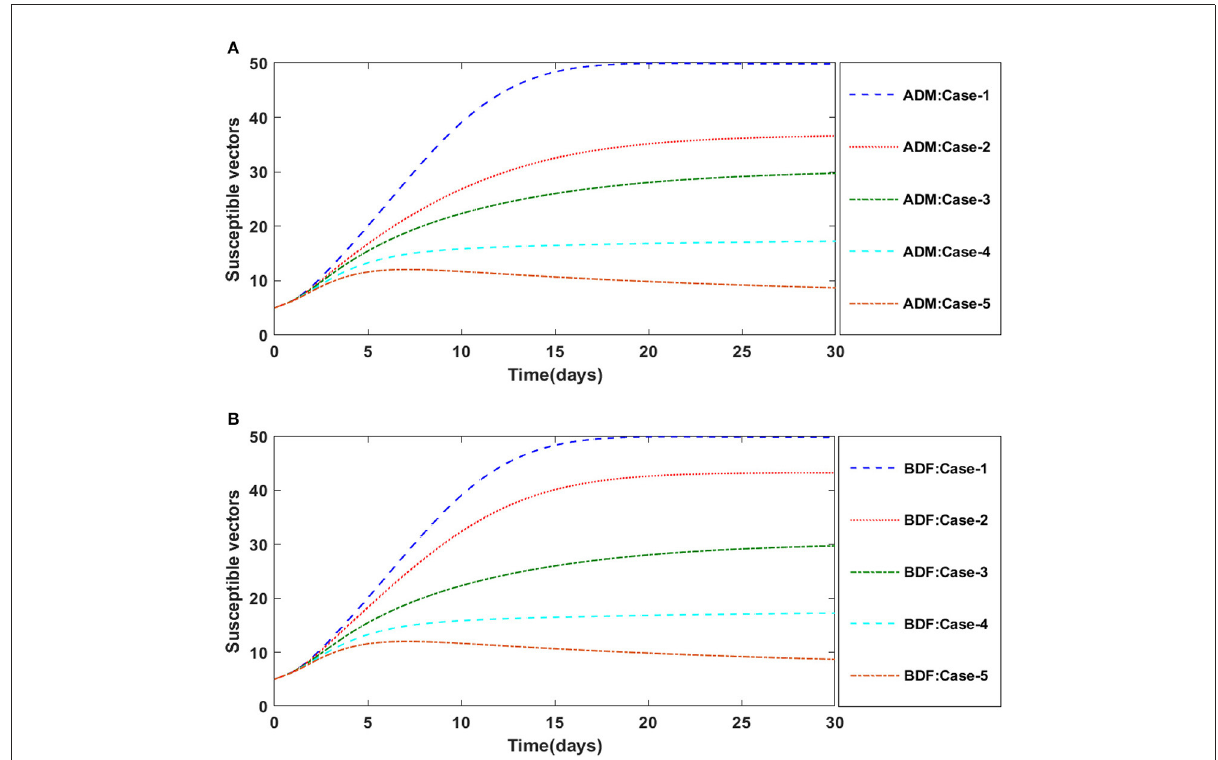
FIGURE24 (A) Dynamics of susceptible vectors for the varition in r using ADM for model B2. (B) Dynamics of susceptible vectors for the varition in r using BDF for model